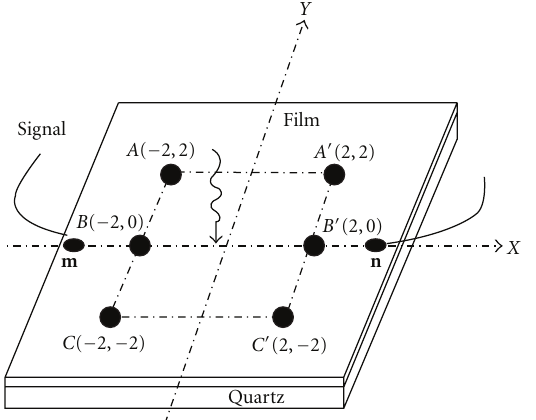
Figure 1: The schematic diagram displays the electrode settings, the laser spot, and the laser spot moving direction.